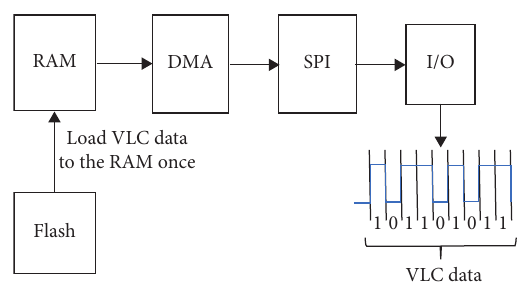
Figure 4: VLC control signal